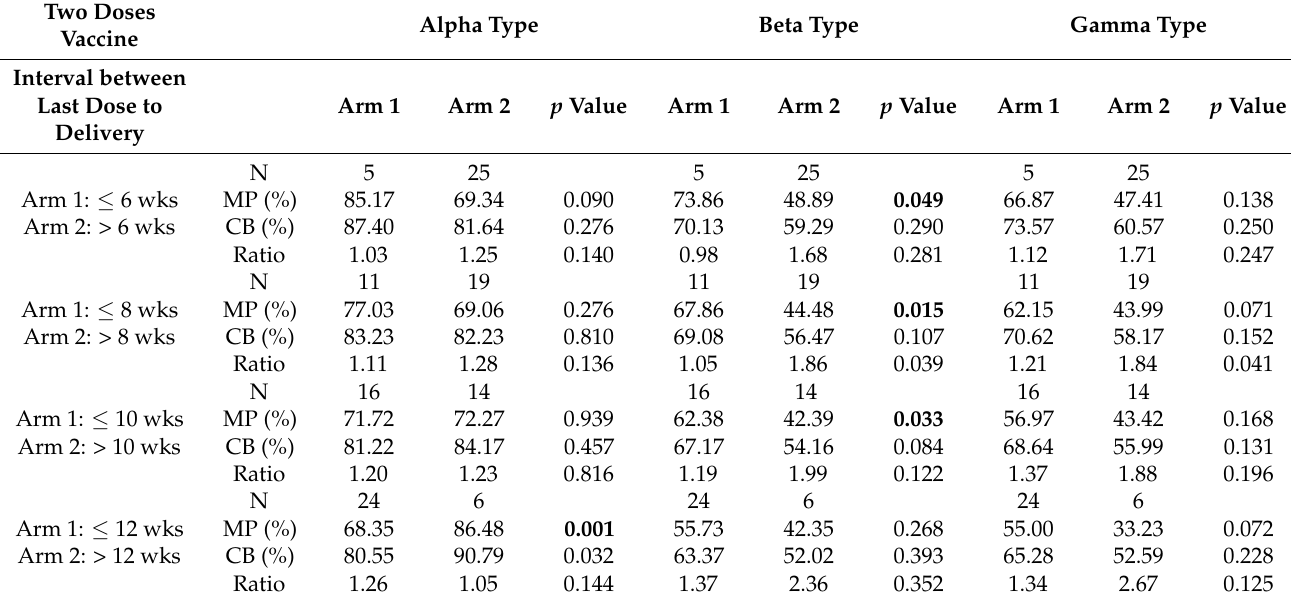
Table 3. SRBD IgG binding ratio for SARS-CoV-2 Alpha, Beta, and Gamma variants with comparisons of different intervals from 2nd COVID-19 vaccine dose to